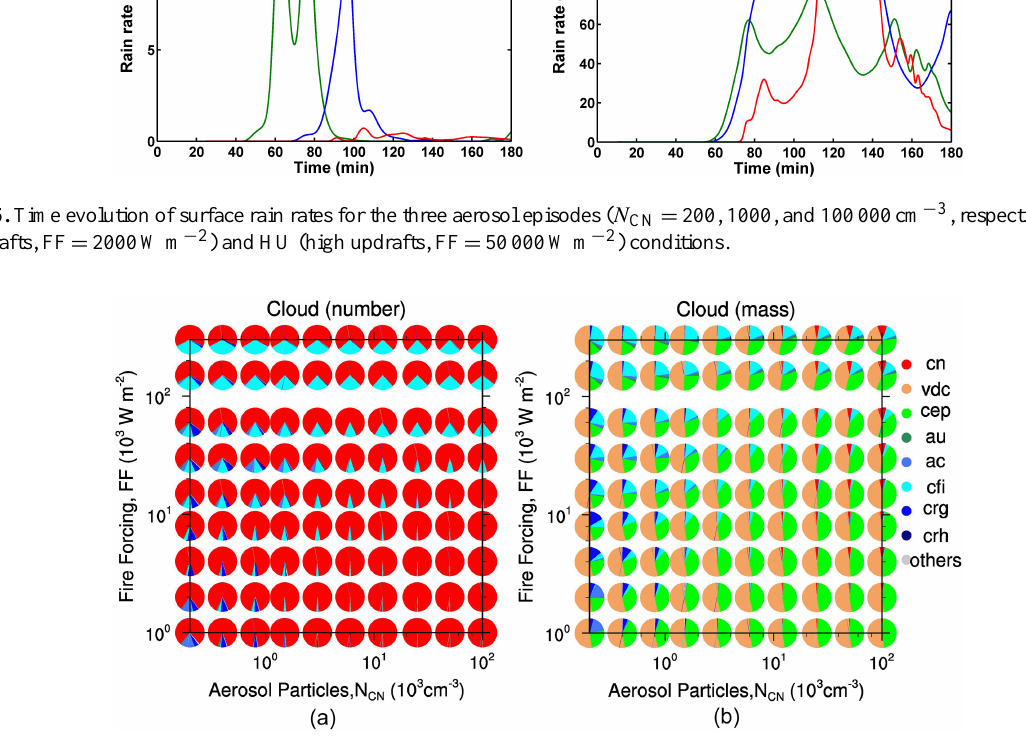
Figure 16. The pie charts summarize the relative percentage of the microphysical processes involving cloud droplets as a function of N CN and fire forcing ( a number concentration, b mass concentration). Colors within each pie chart reflect the contribution of processes under the specific condition. Warm colors denote the sources, while cold colors denote the sinks. Abbreviations are as follows: cn, cloud nucleation; vdc, condensational growth of cloud droplets; cep, evaporation of cloud droplets; au, autoconversion; ac, accretion; cfi, freezing of cloud droplets to form ice crystals, including homogeneous and heterogeneous nucleation; and crg/h, riming of cloud droplets to form